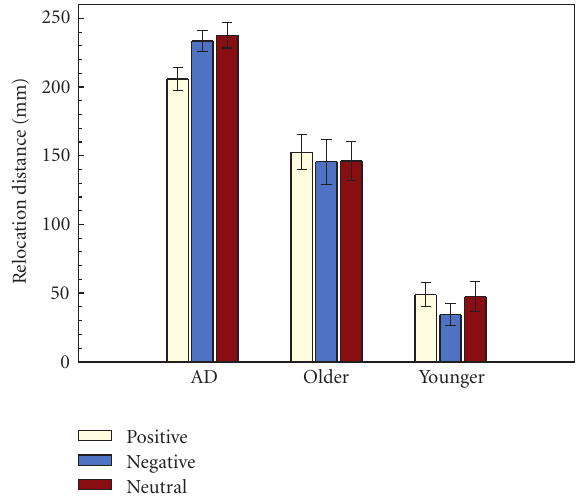
Figure 3: Mean relocation distance scores for positive, negative and neutral pictures in the AD group and control groups. Lower scores represent better performance. Error bars represent the standard error of the